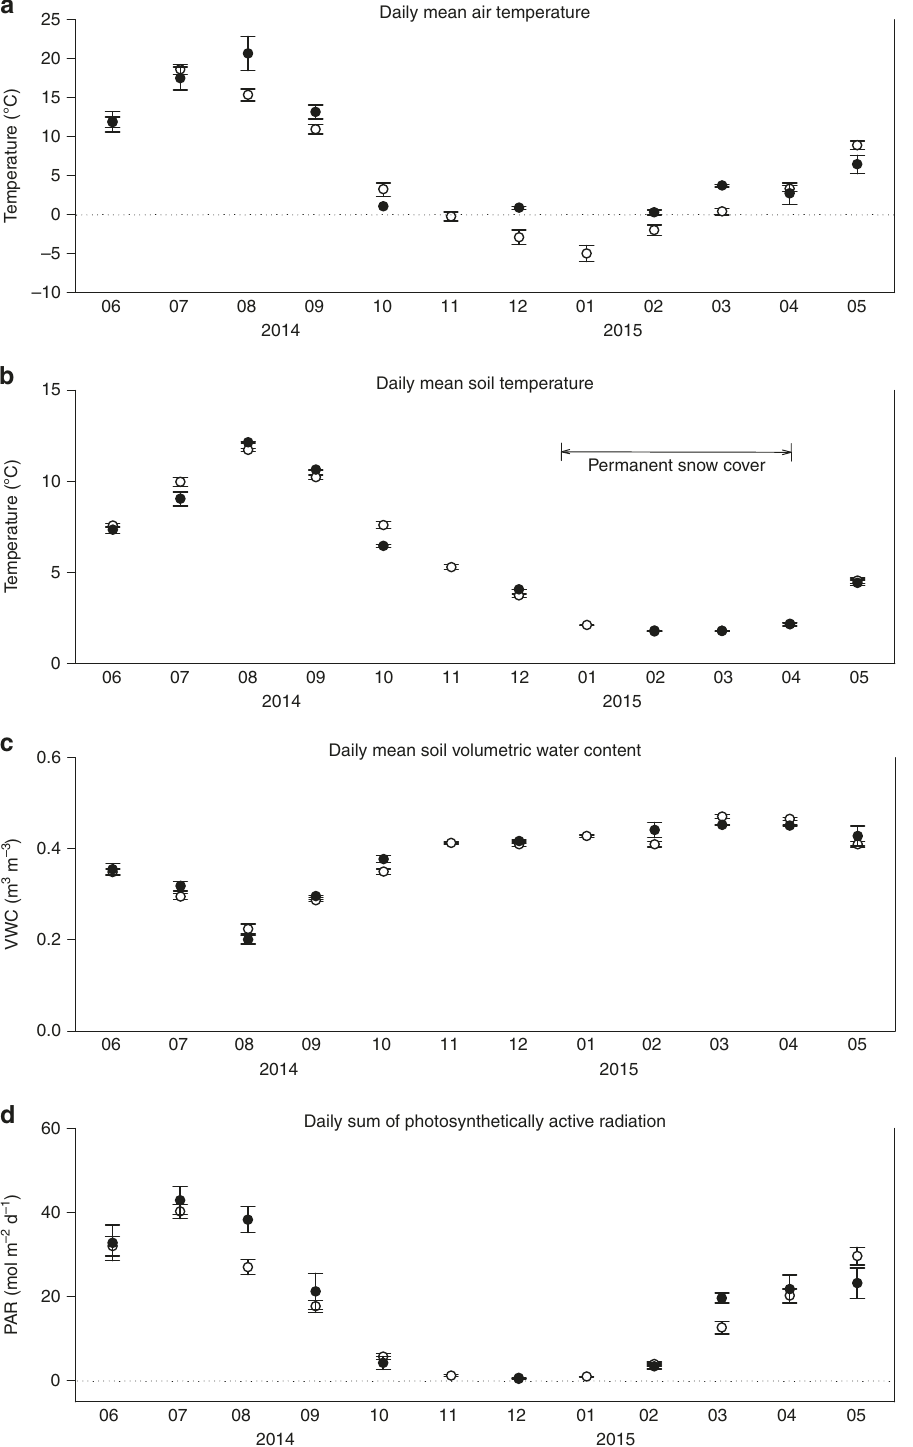
Fig. 2 Seasonal courses of basic environmental variables. The variables were measured at the SMEAR II station from June 2014 to May 2015: ( a ) Daily mean air temperature within the forest stand at 8 m height; ( b ) daily mean soil temperature and ( c ) soil volumetric water content (VWC), both in C1- horizon (38 – 60 cm in depth); and ( d ) daily sum of photosynthetically active radiation (PAR). The open circles represent monthly means (± standard error), and the black circles indicate monthly means ( ± standard error) calculated for the fl ux measurement days only. The period of continuous snow cover (from mid-December 2014 to early April 2015) is indicated in Fig.